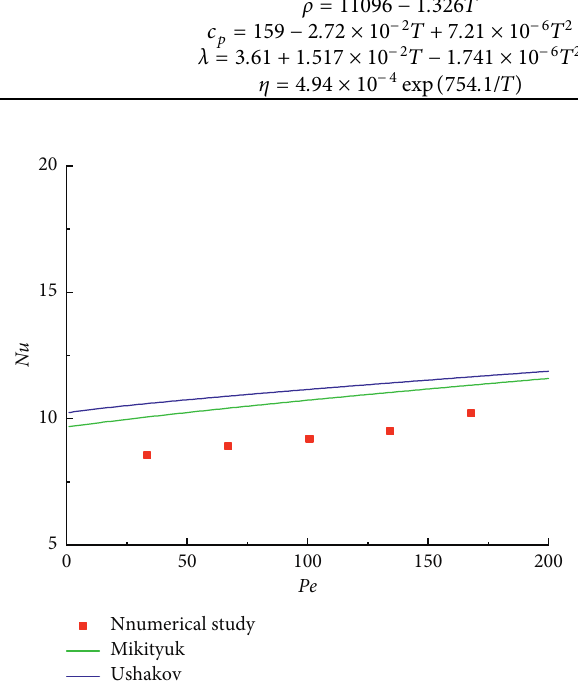
Figure 5: Comparison of numerical calculation results with ex- perimental